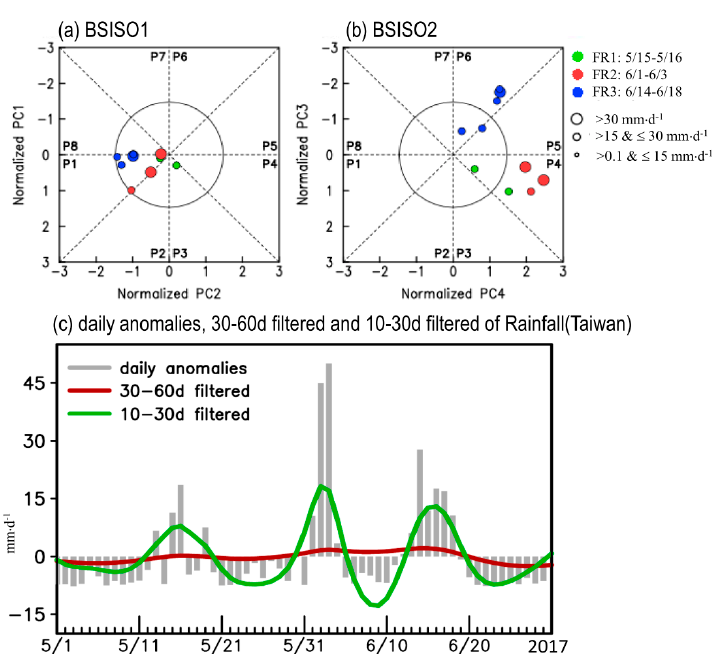
Figure 4. ( a ) The phase (P1-P8 denotes phase 1-phase 8) and amplitude of BSISO1 related to the occurrence of three heavy rainfall events (FR1~FR3) identified in Figure 1. ( b ) is similar to ( a ) but for the phase and amplitude of BSISO2 related to the occurrence of FR1~FR3 events. In ( a )-( b ), the meaning of the color and size of the dots is explained in the right panel of ( b ). Following Lee et al. [10], a large open circle indicating the amplitude of BSISOs equal to 1.5 is added in ( a )-( b ) to clarify whether the BSISOs is stronger (i.e., amplitude > 1.5) or weaker (i.e., amplitude ≤ 1.5). ( c ) The time series of daily anomalies (i.e., removed the mean of May and June 2017, gray bars), 10 to 30 day band pass filtered (green line) and 30 to 60 day band pass filtered (red line) of daily rainfall area averaged over Taiwan (120-122° E, 22-25.5° N) during May and June 2017.